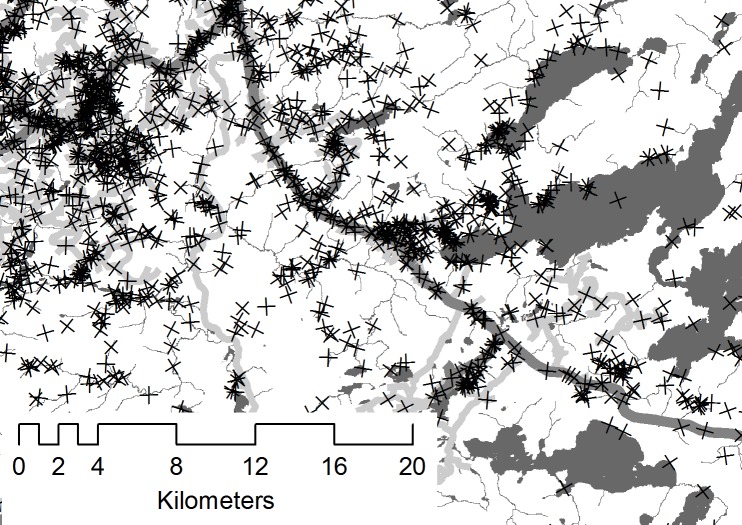
Filtered GPS fixes (crosses) of 5 wolves in the Nakina study area, 2010–2014.Dark grey shading and thin lines are streams, rivers, and lakes; thick dark lines are primary roads, and thick light lines are tertiary roads.